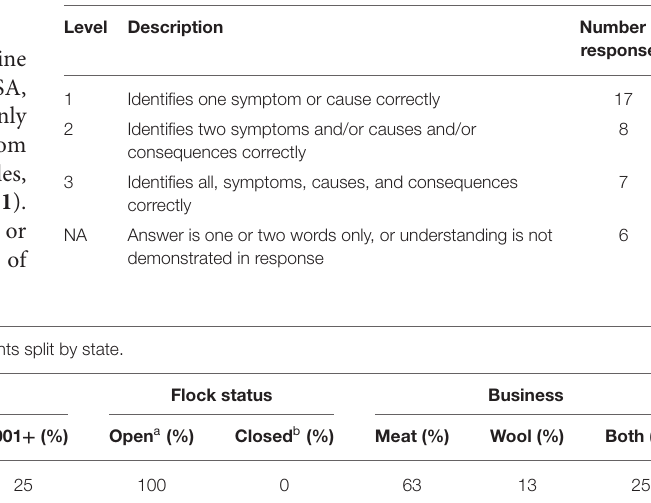
TABLE 2 | A description of the criteria for each level of understanding when it comes to the footrot.